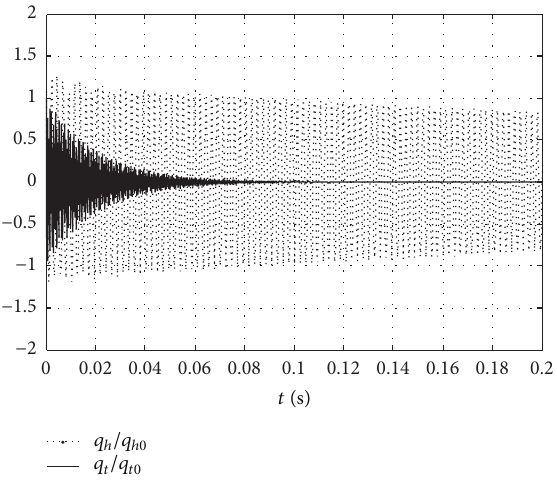
Figure 9: Displacement versus time plot of the generalized coordi- nate of the beam with piezoelectric attachment, 𝑅 = 0.01 , 𝜇 𝑥ℎ1 = 30 , = 0.2 , 𝑈 = 95 m/s, and 𝑉 𝜇 V ℎ1